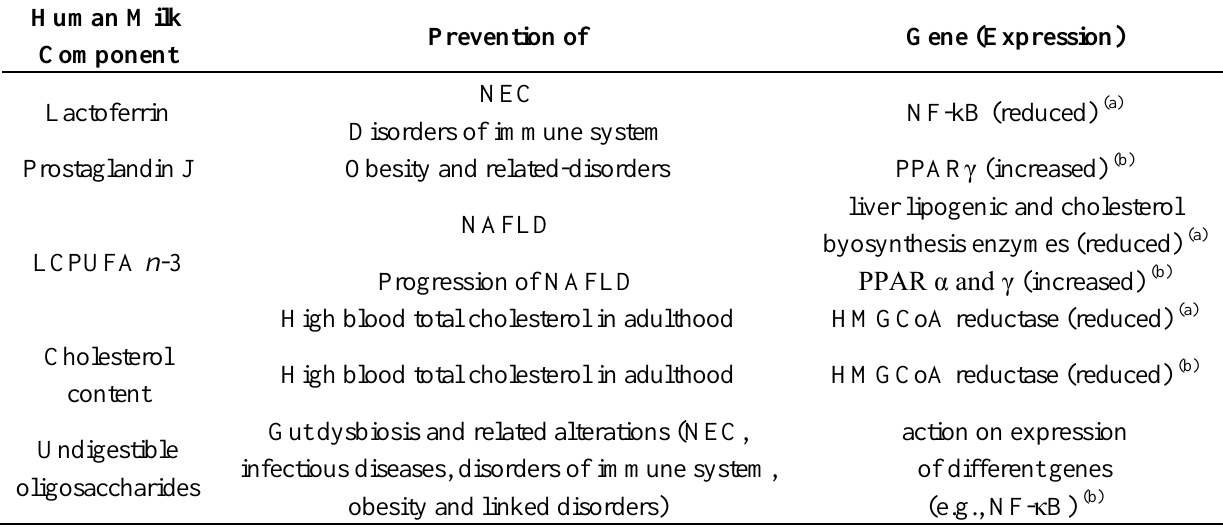
Table 1. Epigenetic effect of human breast milk components on the child’s health